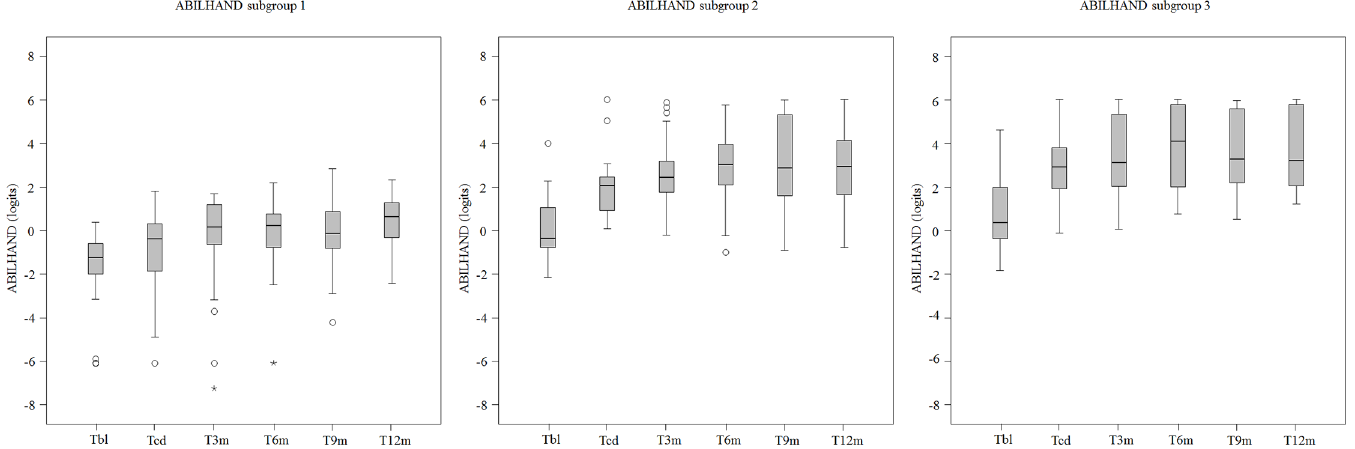
Fig 5. Boxplots of the ABILHANDresults per measurement moment for each of the three groups. T BL = Baseline;T CD = ClinicalDischarge; T 3m = (= T CD + 3 months); T 6m (= T CD + 6 months); T 9m (= T CD + 9 months);T 12m (= T CD + 12 months). Circles = outlier value; Asterisk = far out value.